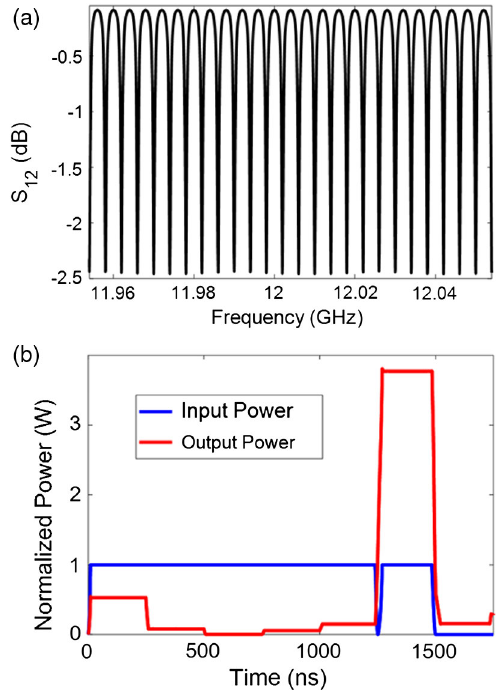
FIG. 1. (a)Centerpart ofthe transmissionspectrum and (b) wave- forms of SLED-II. Operation frequency is 11.994 GHz. Output pulse length is 250